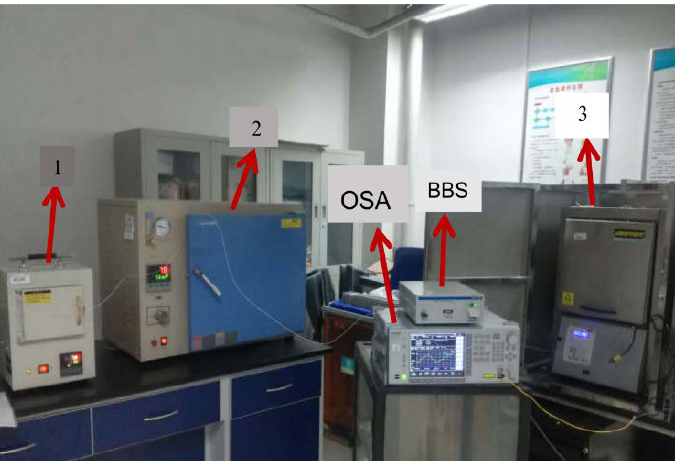
Figure 4. The spatial frequency spectra of Mach–Zehnder interferometers (MZIs), and the inset is the correlated interference spectra with different sensing arms of 0.8 cm, 1.2 cm, and 4.3 cm.